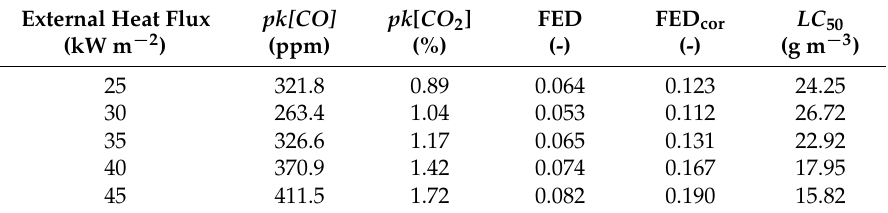
Table 3. Results of gas concentration and toxicity